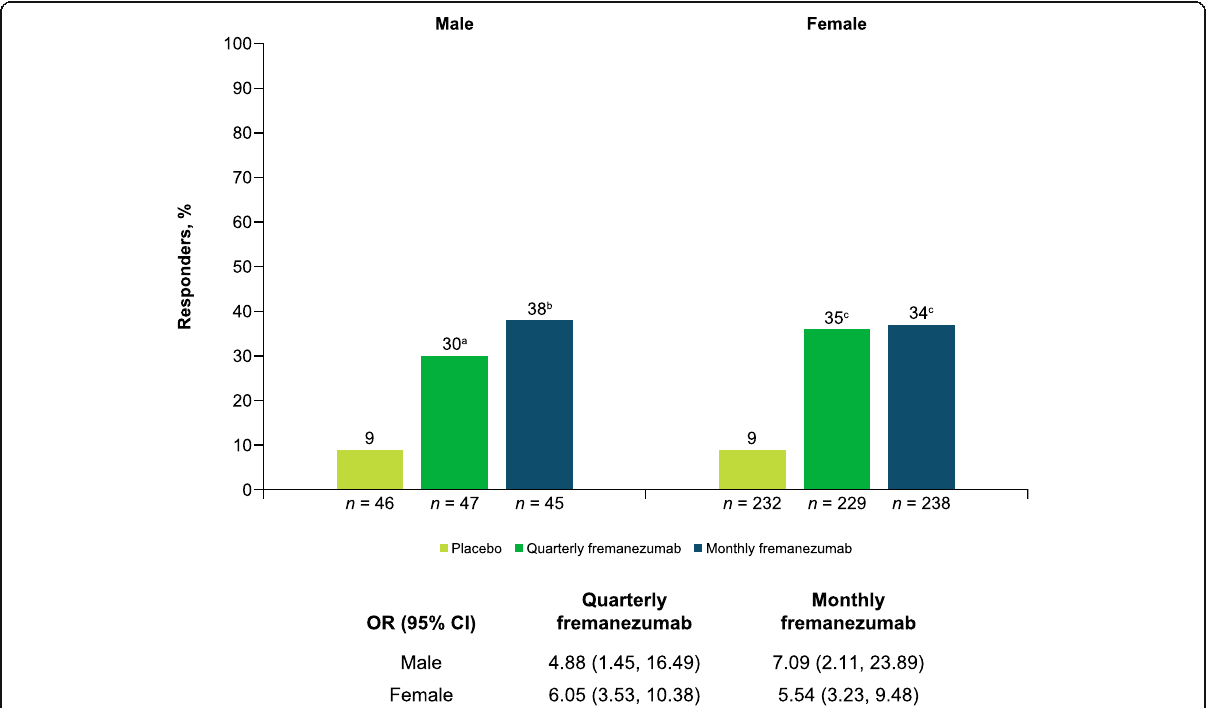
Fig. 5 Proportion of patients with ≥ 50% reduction in monthly migraine days from baseline during 12weeks by sex. OR, odds ratio; CI, confidence